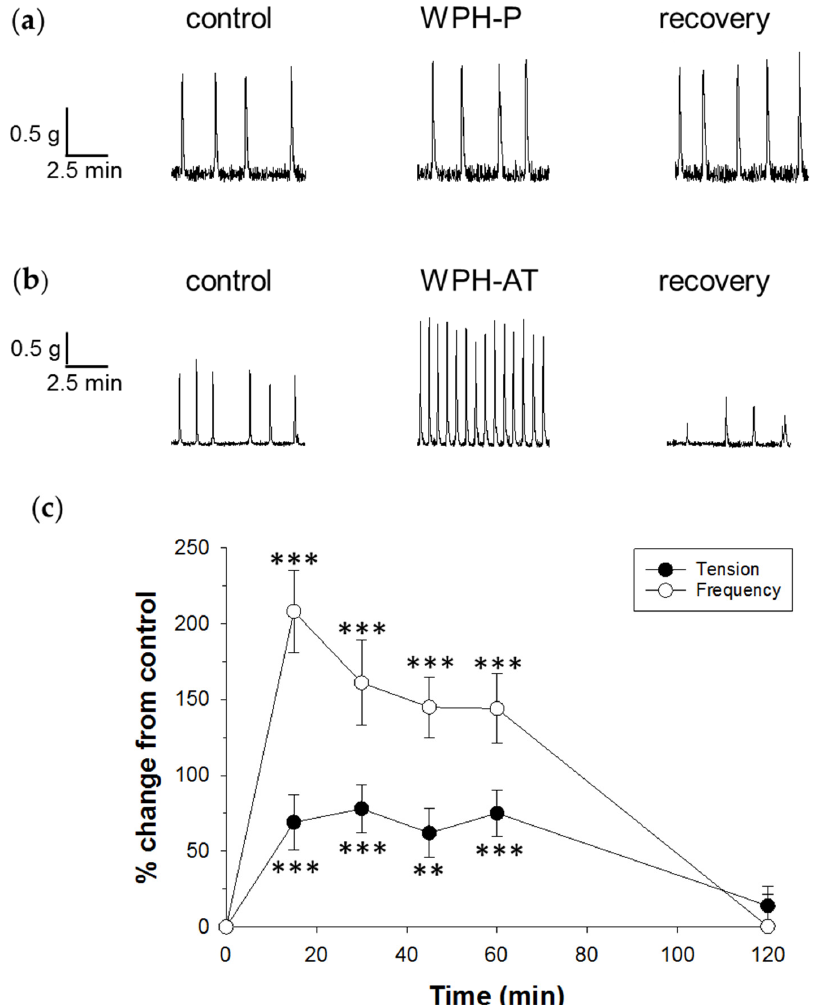
Figure 3. Effect of WPH on spontaneous smooth muscle contractions in the rat distal colon. Examples of raw data recordings from two separate experiments show changes in muscle tension over time for the control, after addition of 1 mg/mL ( a ) WPH-P; n = 12; ( b ) WPH-AT; n = 11, and the last 10 min of recovery following a 60 min washout in Krebs buffer; ( c ) Time-dependence of WPH-AT effect shown as percent change in tension and frequency from the pretreatment control for a 60 min application showing, pooled data from 12 experiments. Treatment with WPC-AT was applied for 60 min ( n = 11). Data show mean ± SEM. Asterisks indicate the significance of each treatment relative to controls (** p < 0.01, *** p < 0.001).